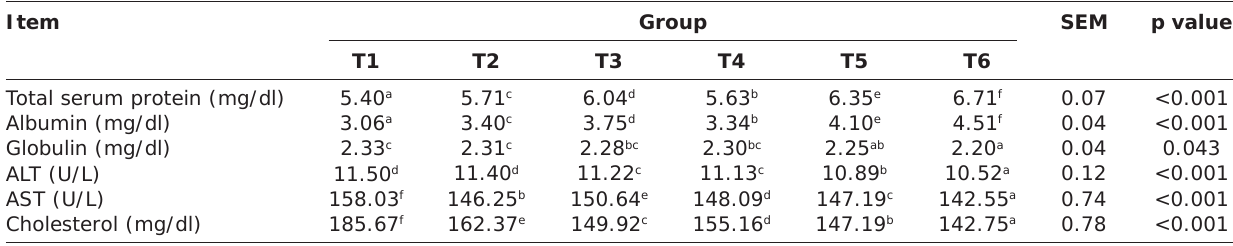
Table-3: Effect of shatavari and vitamin E on biochemical parameters in different groups during winter season. Item Group SEM